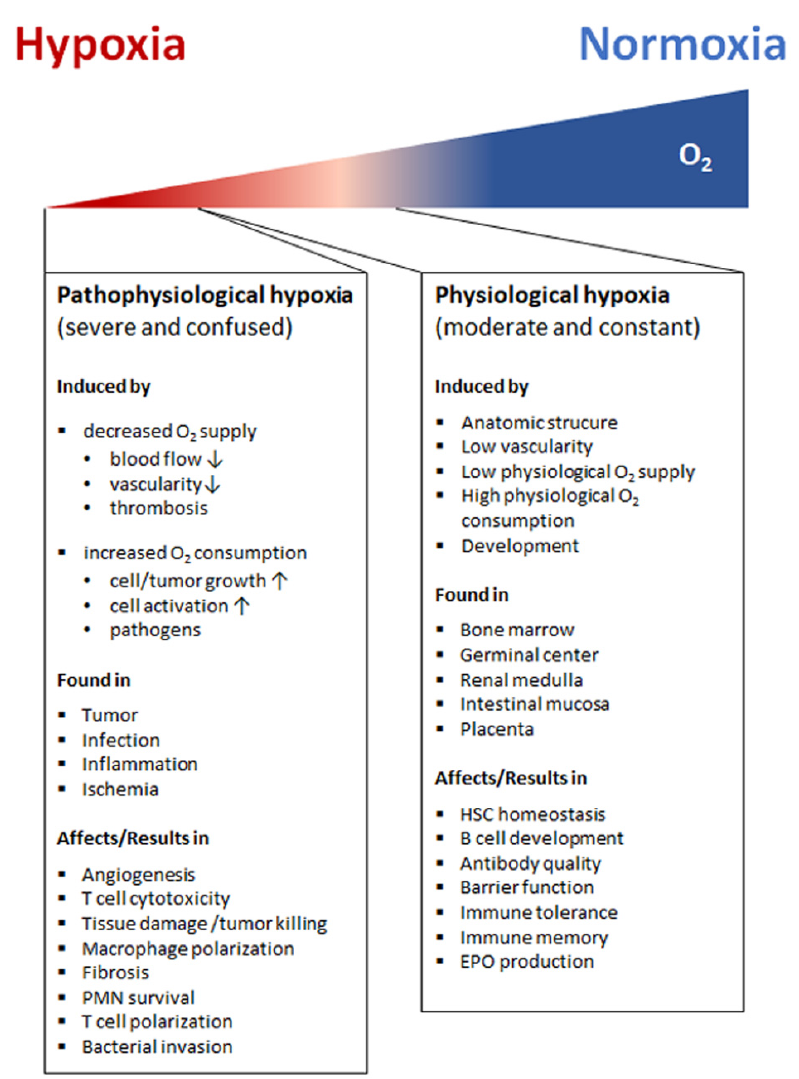
Figure 2. Hypoxia arises in a variety of immunological situations under physiological and pathophysiological immune activity. Physiological hypoxia which is attributed to be moderate and constant is caused by, e.g., oxygen gradients as a result of developmental processes, anatomic structure and functional composition. The factors contributing to physiological hypoxia differ in specific organs such as in primary and secondary lymphoid organs. Here, physiological hypoxia regulates the function of immune cells supporting beneficial immune activity (light red right panel). The pathophysiological hypoxia is usually attributed to be severe and confused, which is caused by a variety of factors in different diseases (dark red left panel). ( ↑ : induced or up-regulated, ↓ : reduced or down-regulated. PMN, polymorphonuclear neutrophils; EPO, erythropoietin; HSC, hematopoietic stem